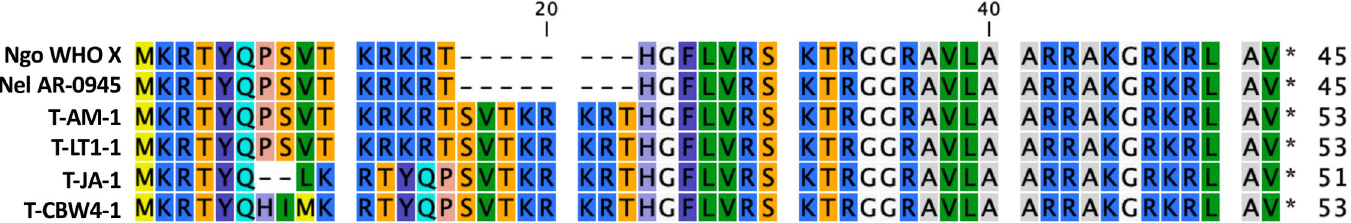
PLOS ONE | https://doi.org/10.1371/journal.pone.0262370 January 13,